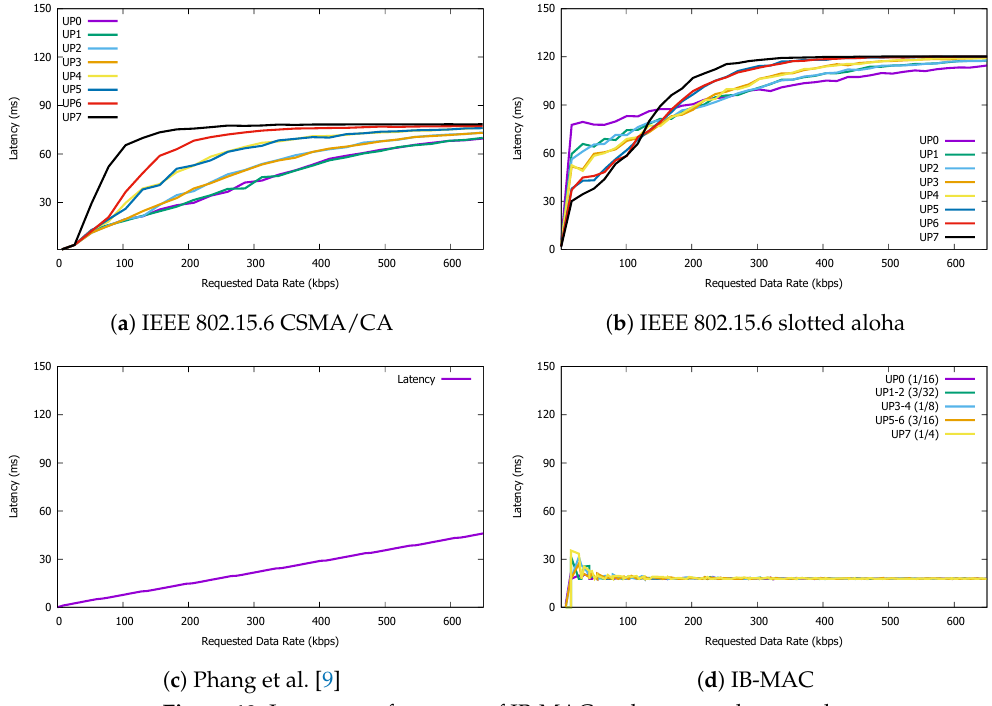
Figure 18. Latency performance of IB-MAC and compared